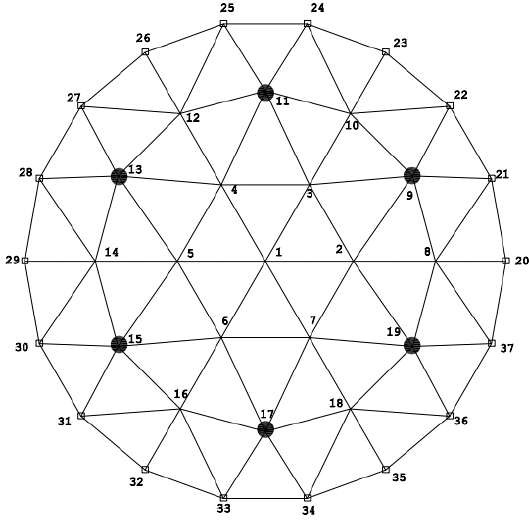
Figure 5. The optimal sensor placement positions.